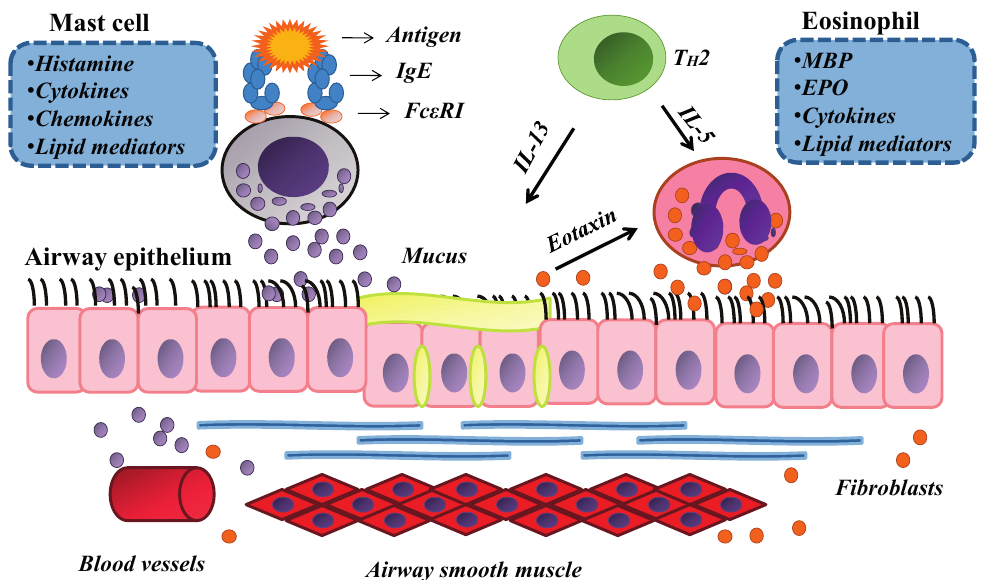
Figure 2. Pathophysiological Mechanisms in